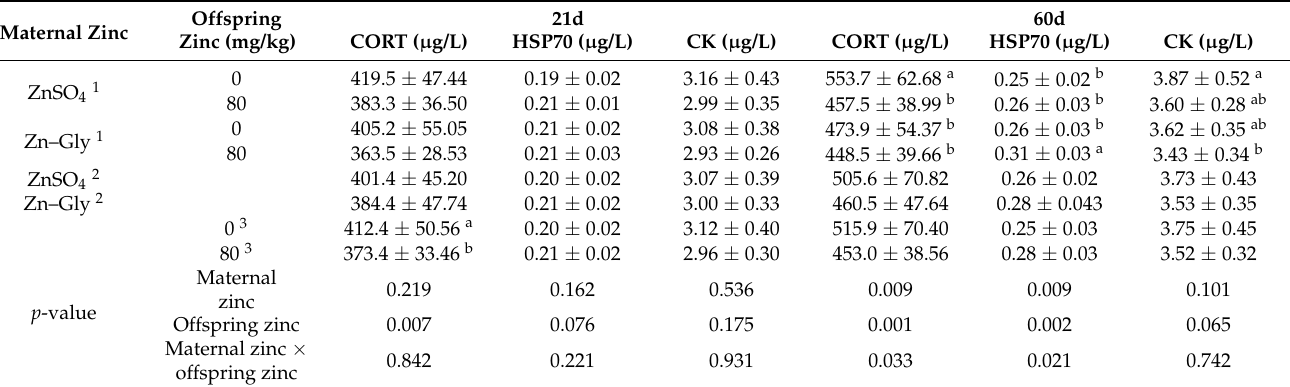
Table 10. Effects of maternal Zn in conjunction with offspring dietary Zn supplementation on stress indexes in serum of offspring broilers (mean ±